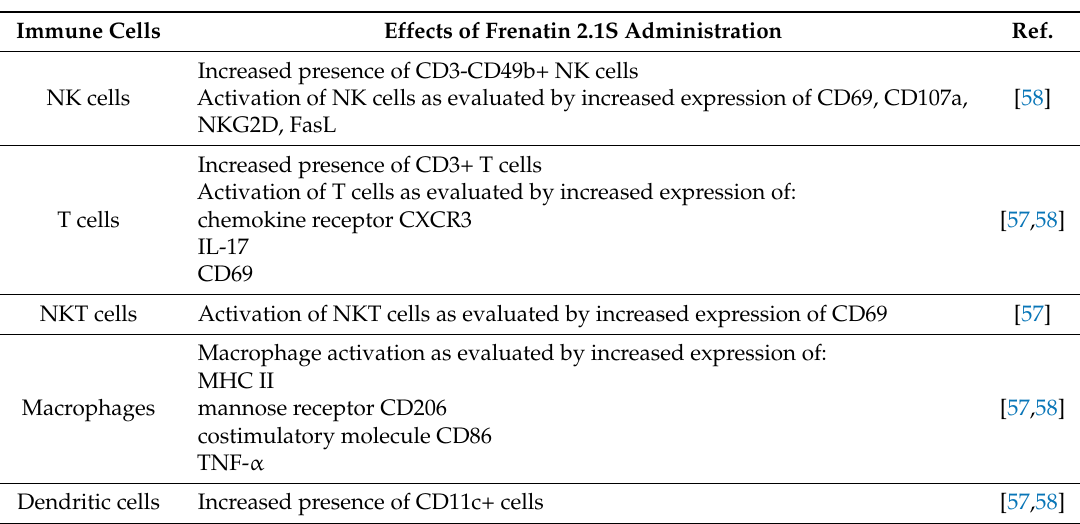
In vivo effects of the frog skin-derived peptide frenatin 2.1S on murine peritoneal mononuclear cells. Immune Cells Effects of Frenatin 2.1S Administration